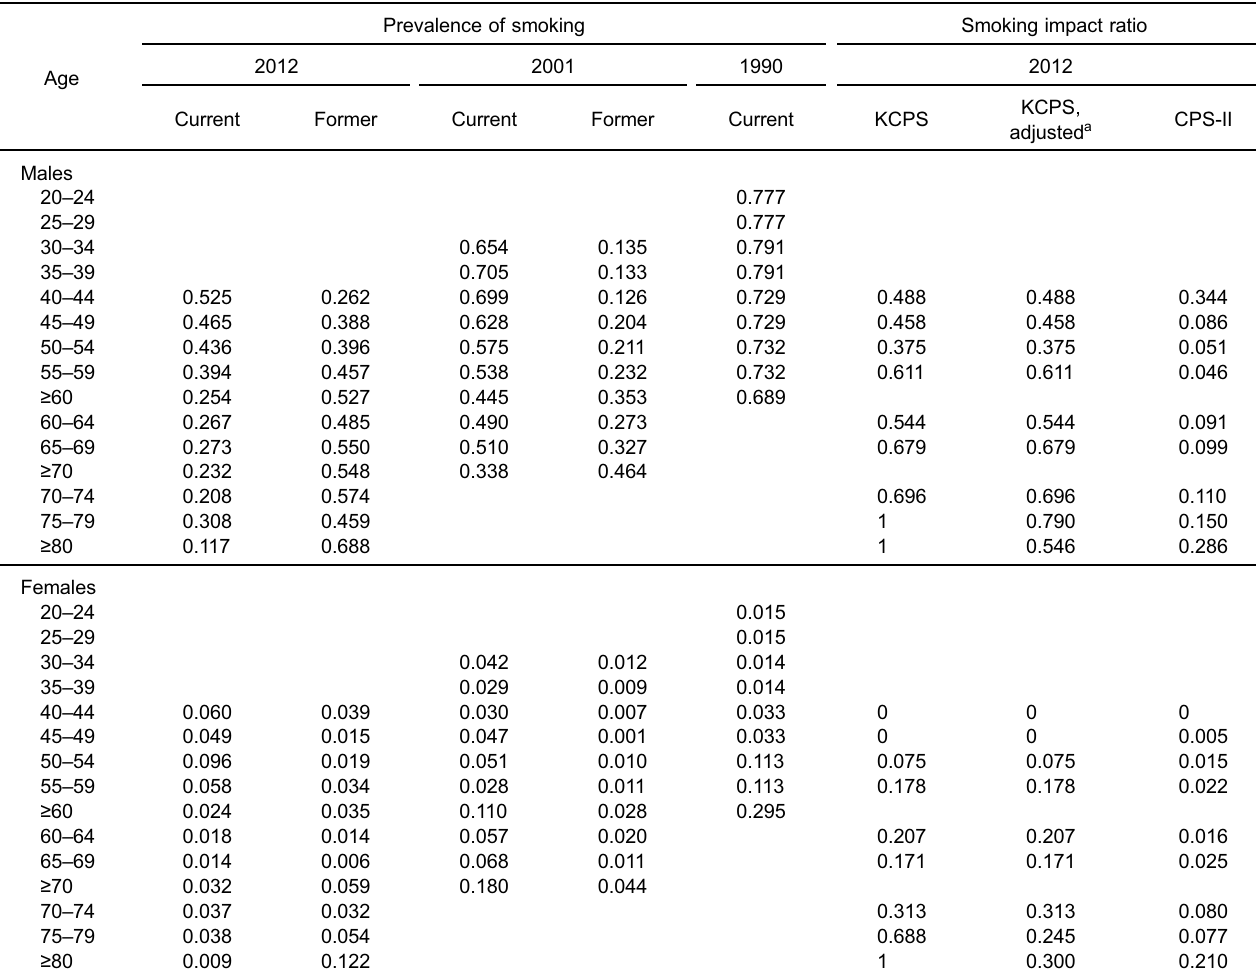
Table 2. Smoking impact ratios and prevalence of current and former smoking in Korea